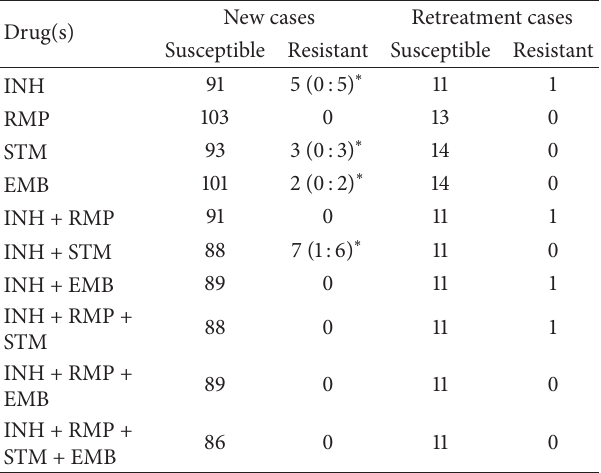
Table 1: Number of drug susceptible or resistant isolates in new and retreatment TB